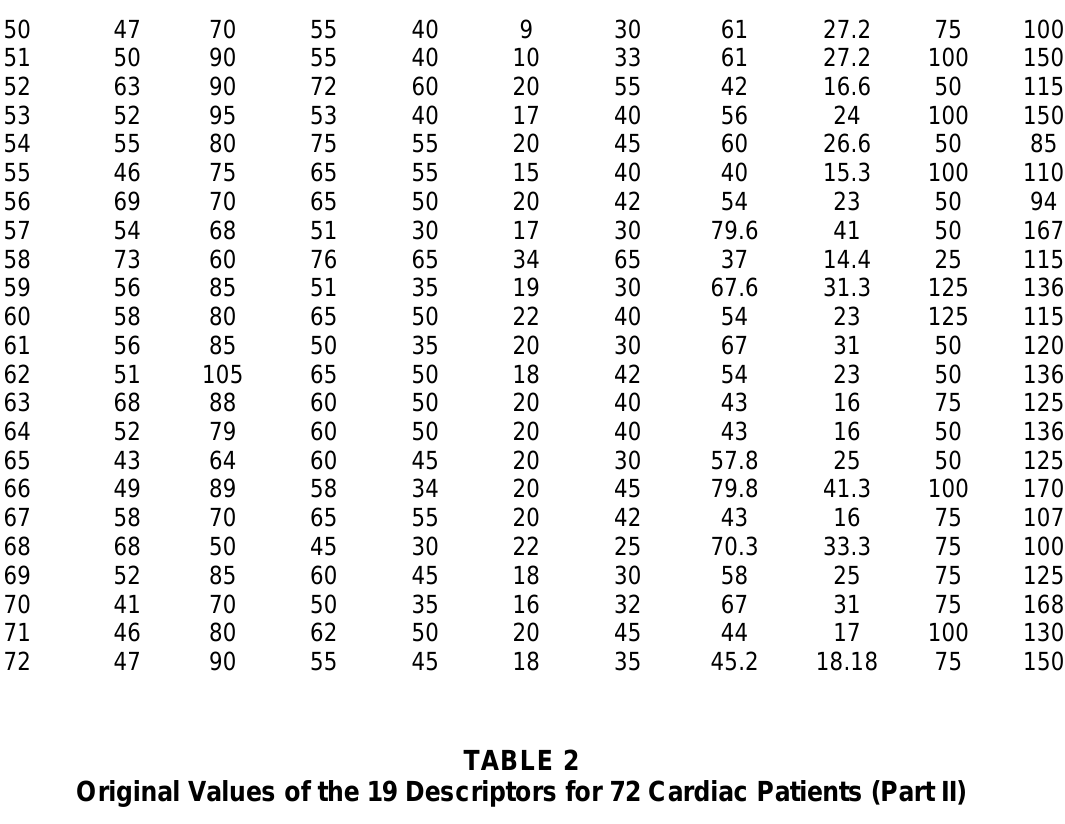
Original Values of the 19 Descriptors for 72 Cardiac Patients (Part